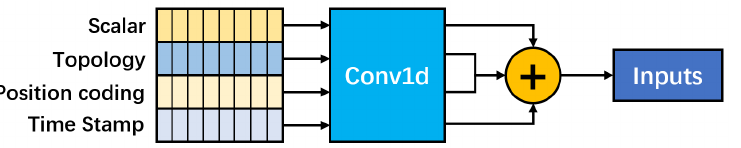
Figure 3. The process of embedding of traffic